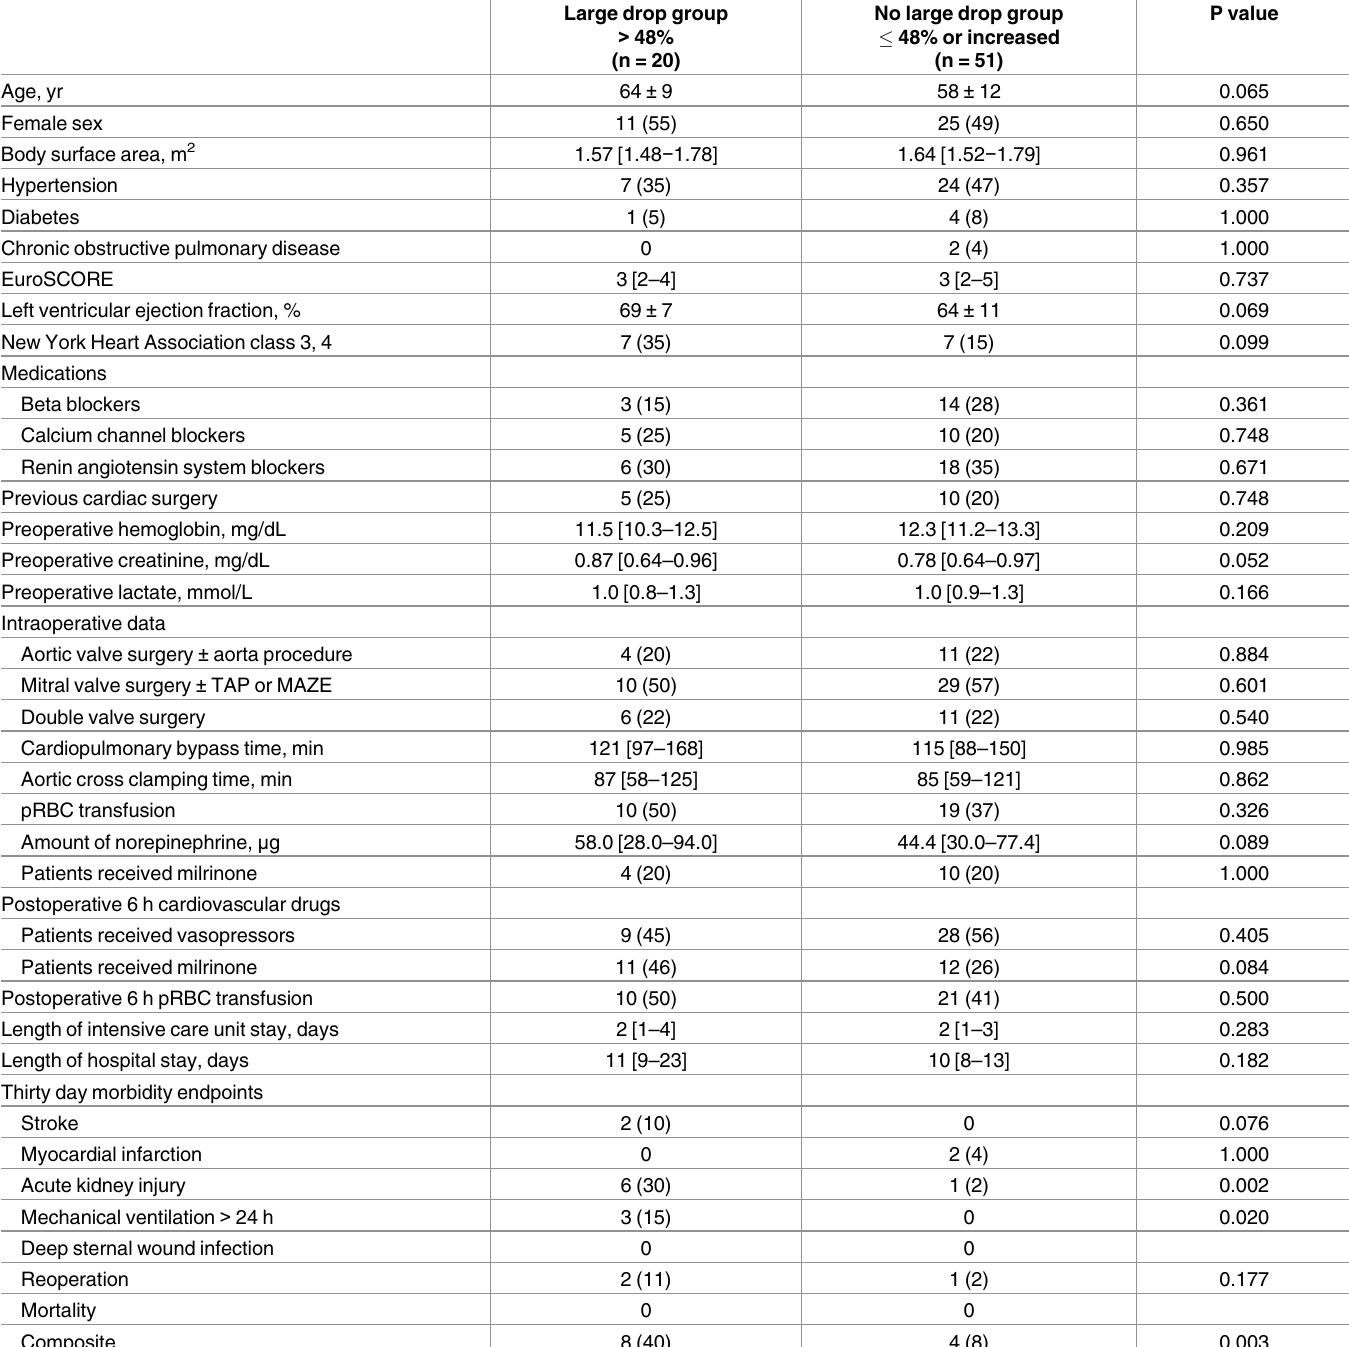
Table 3. Perioperative data according to the % change of SPP during CPB from the baseline